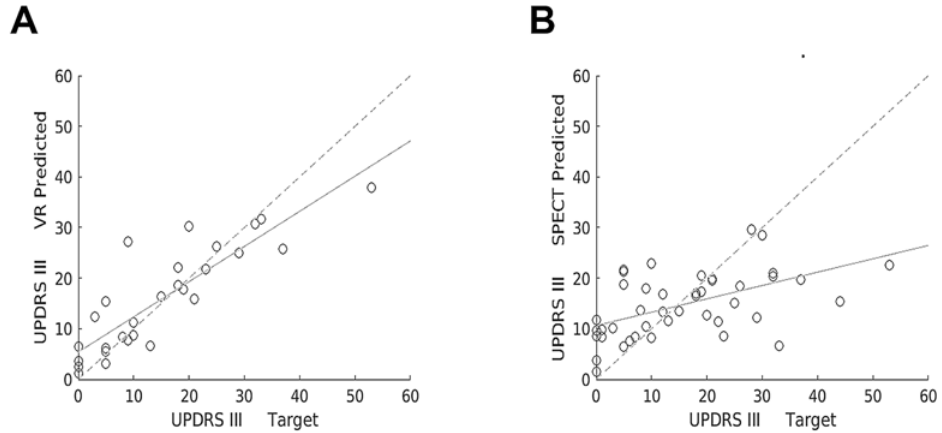
Table 4. Logistic regression results comparing age, gender, hand dominance, Parkinson disease